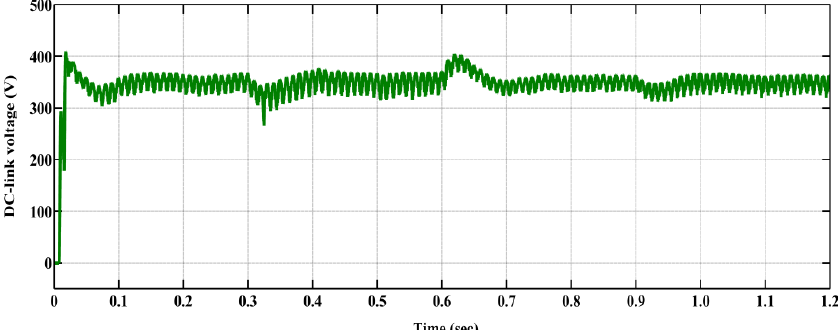
Figure 6. Simulation result with composite load (linear and non ‐ linear): DC ‐ link voltage.